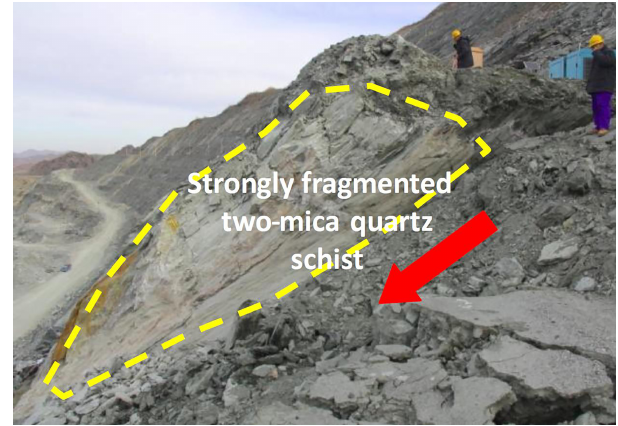
Figure 4. Slip surface consisting of strongly fragmented two-mica quartz